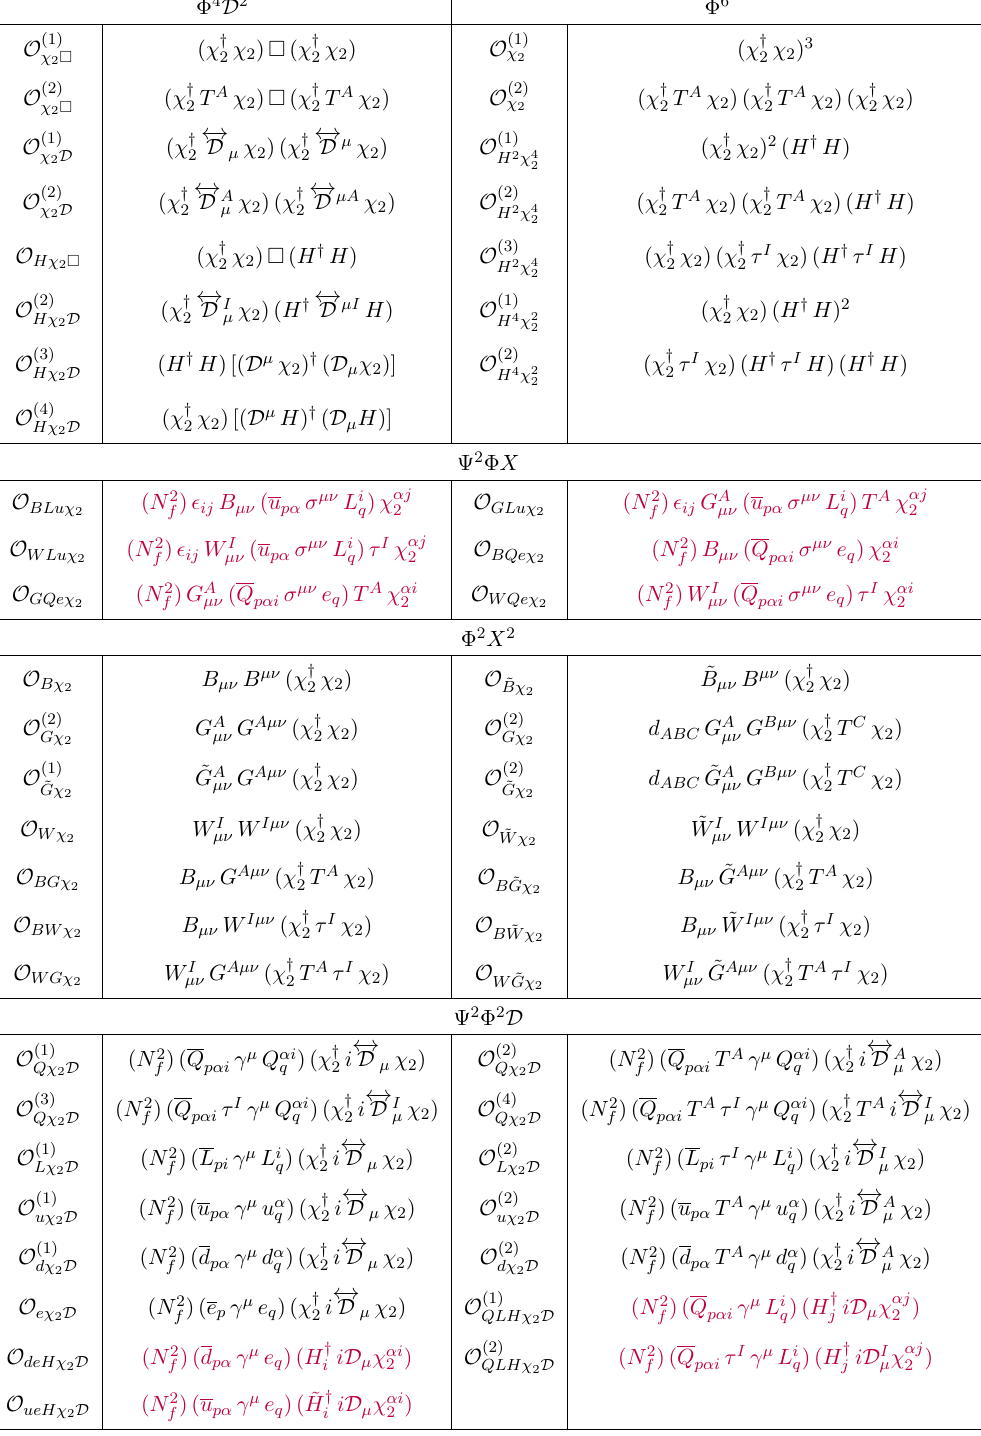
Table 37 . SM extended by Lepto-Quark ( χ 2 ): additional operators of dimension 6. Here i, j and α are the SU(2) and SU(3) indices respectively. T A and τ I are SU(3) and SU(2) generators respectively. A, B, C = 1 , 2 , · · · , 8 and I = 1 , 2 , 3 . p, q = 1 , 2 , · · · , N f are the flavour indices. Operators in red violate lepton